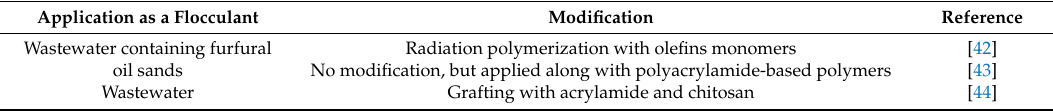
Table 2. Lignosulfonate as a flocculant in different